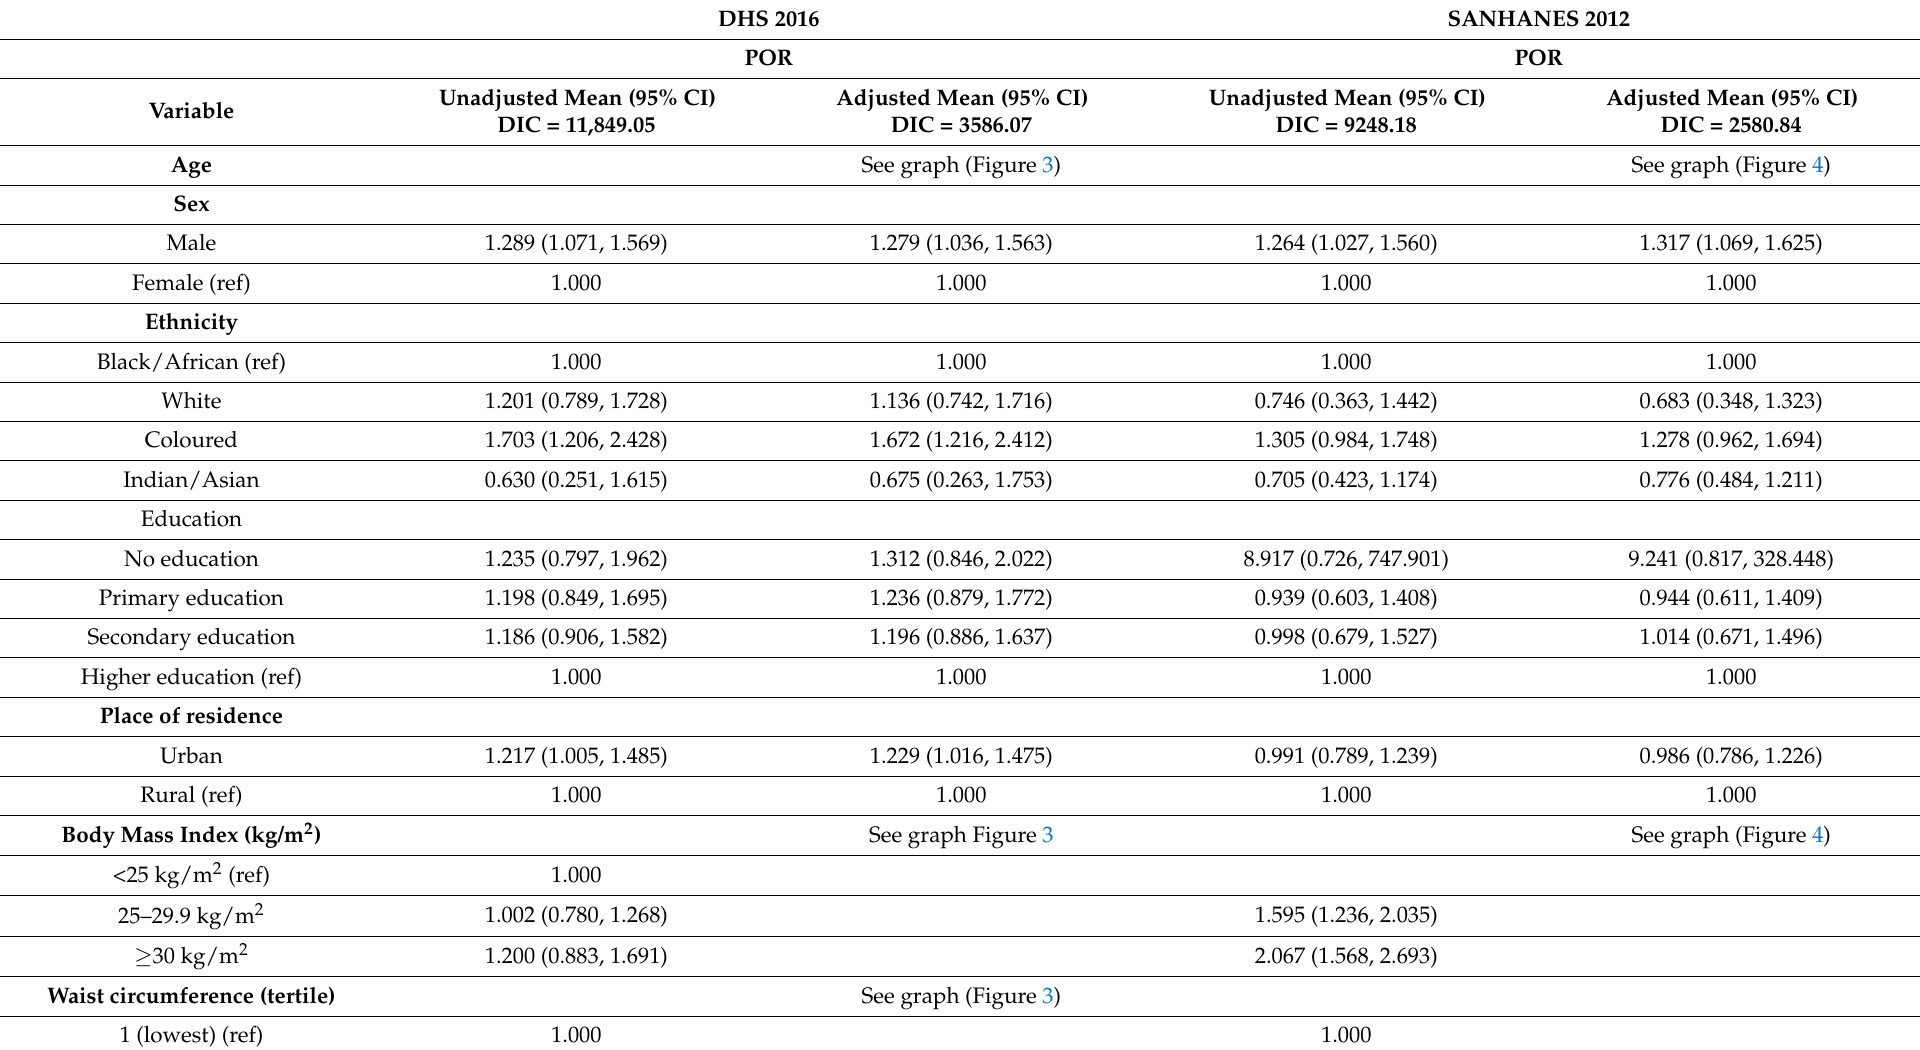
Table 2. Adjusted and unadjusted estimates of the posterior odds ratio (POR) from the Bayesian geo-additive regression